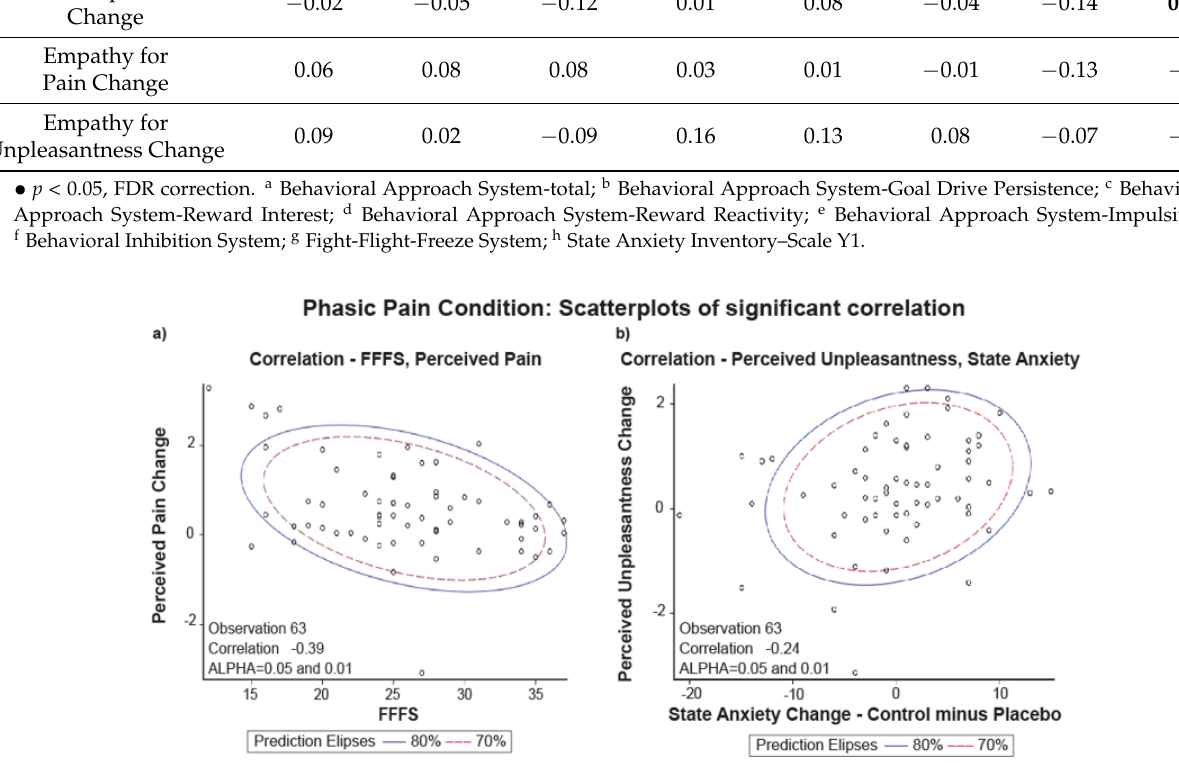
Figure 3. Phasic Pain Condition: ( a ) scatterplot of Pearson correlation between FFFS and Perceived Pain Change (Control minus Placebo, N = 63); ( b ) scatterplot of Pearson correlation between perceived Unpleasantness and State Anxiety Change (Control minus Placebo, N = 63).